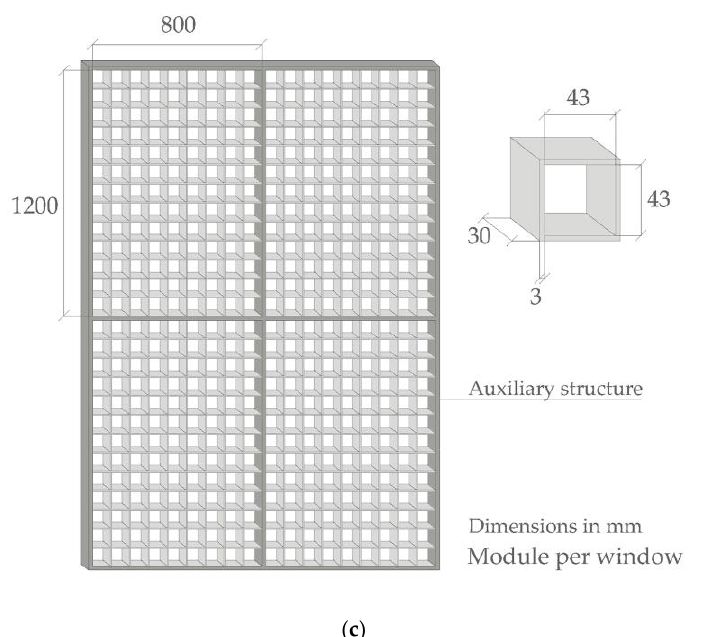
Figure 3. ( a ) Indoor view of the classroom with no egg-crate devices (room B); ( b ) indoor view of